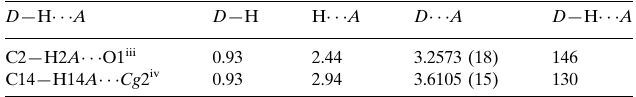
Hydrogen-bond geometry (A˚ , (cid:1) ). Cg 2 is the centroid of the C9–C14 benzene